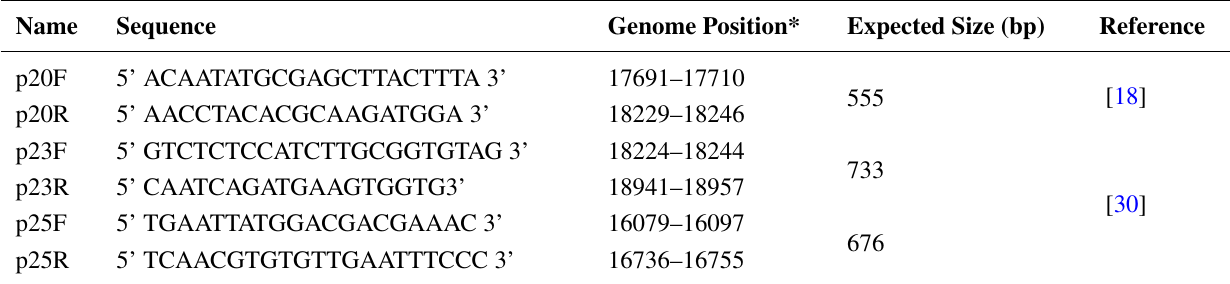
Table 3. List of primers used in this work. Nucleotide sequence, genome position, expected size and author reference are